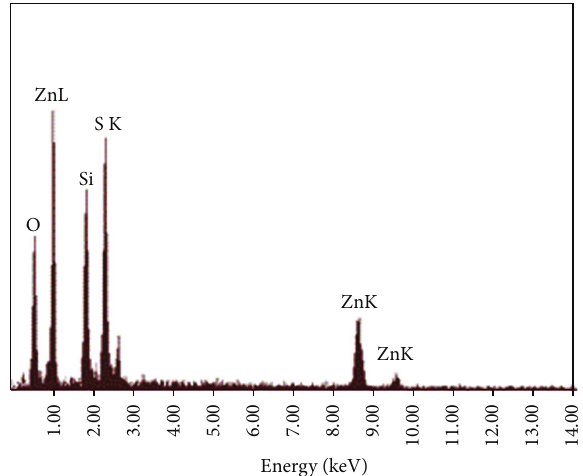
Figure 5: EDX spectrum of ZnS@SiO 2 core-shell nanocomposites.